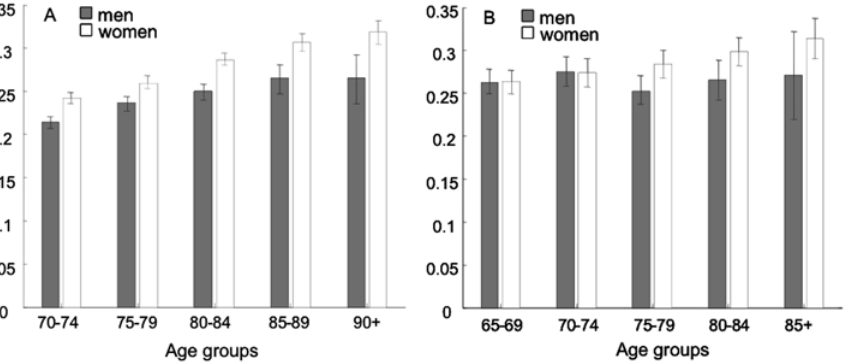
Figure 3. Mean (95% Confidence Interval) social vulnerability in relation to age and sex. Panel A) In the Canadian Study of Health and Aging, social vulnerability increased with age and women had higher index scores than men at all ages. Panel B) In the National Population Health Survey, women showed a trend towards higher scores at older ages.